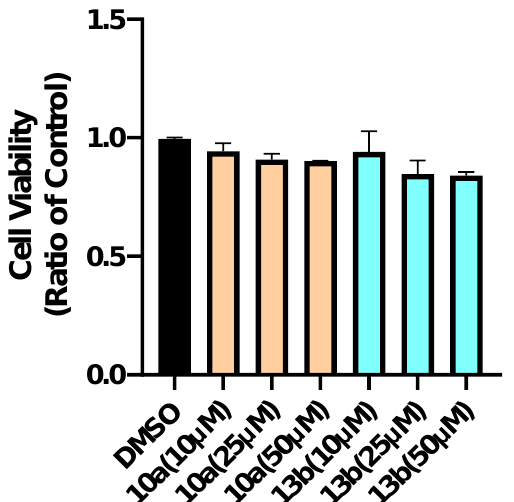
Figure 4. Cell viability of compounds 10a and 13b on SH-SY5Ycells. All values were expressed as mean ± SEM from three independent experiments.